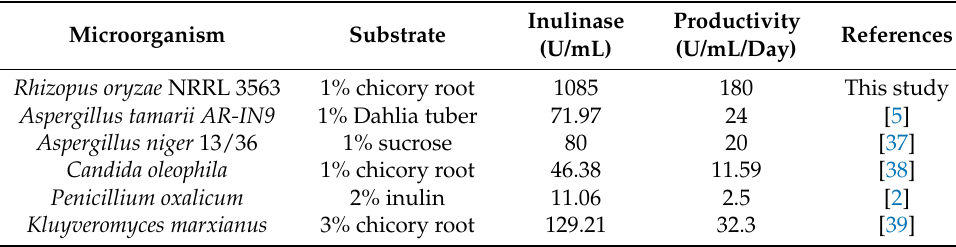
Table 8. Comparison of inulinase production from various substrates in fermentation by Rhizopus oryzae NRRL 3563 and other fungi. Microorganism Substrate